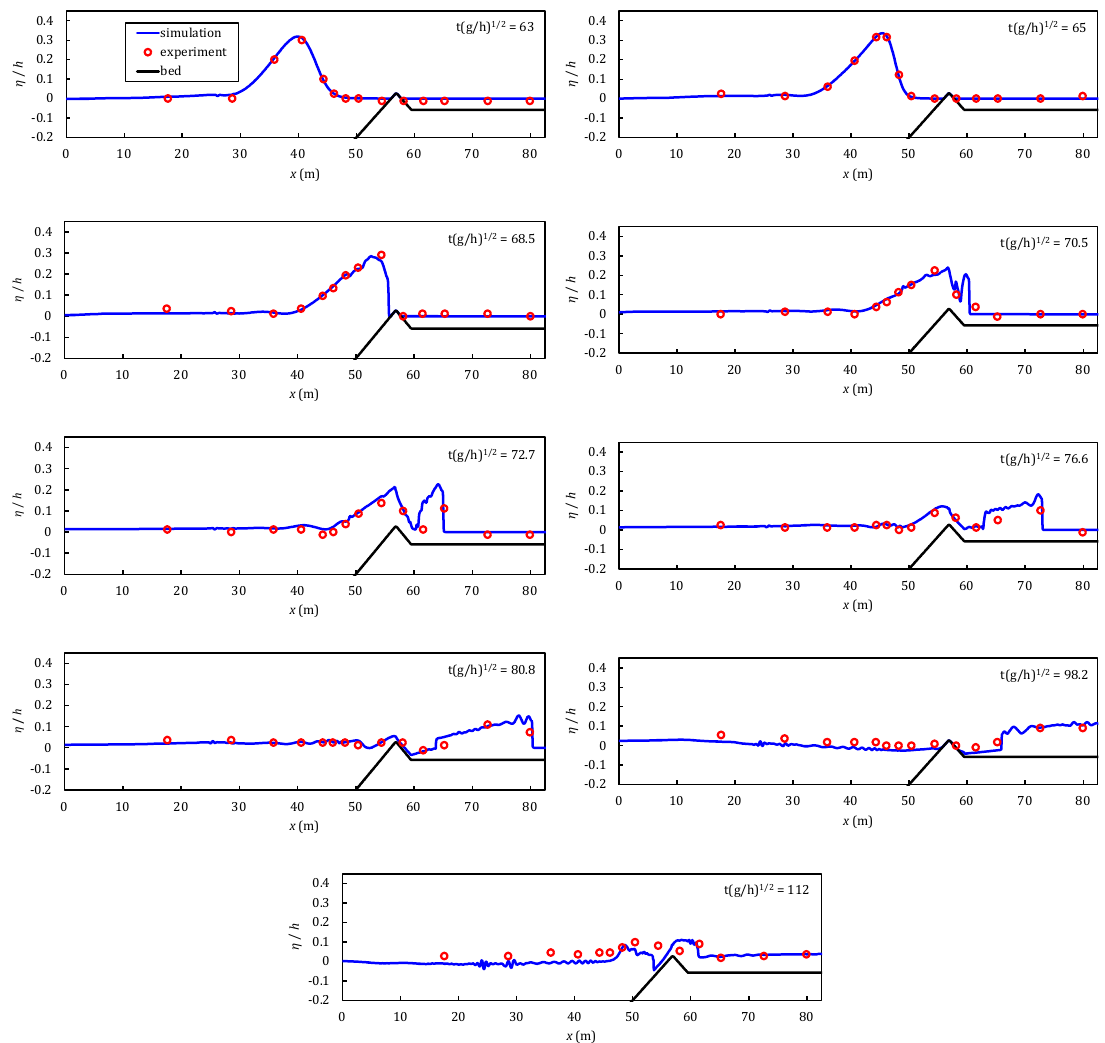
Figure 8. Comparisons between simulated and experimental surface elevations for propagation of solitary wave over fringing